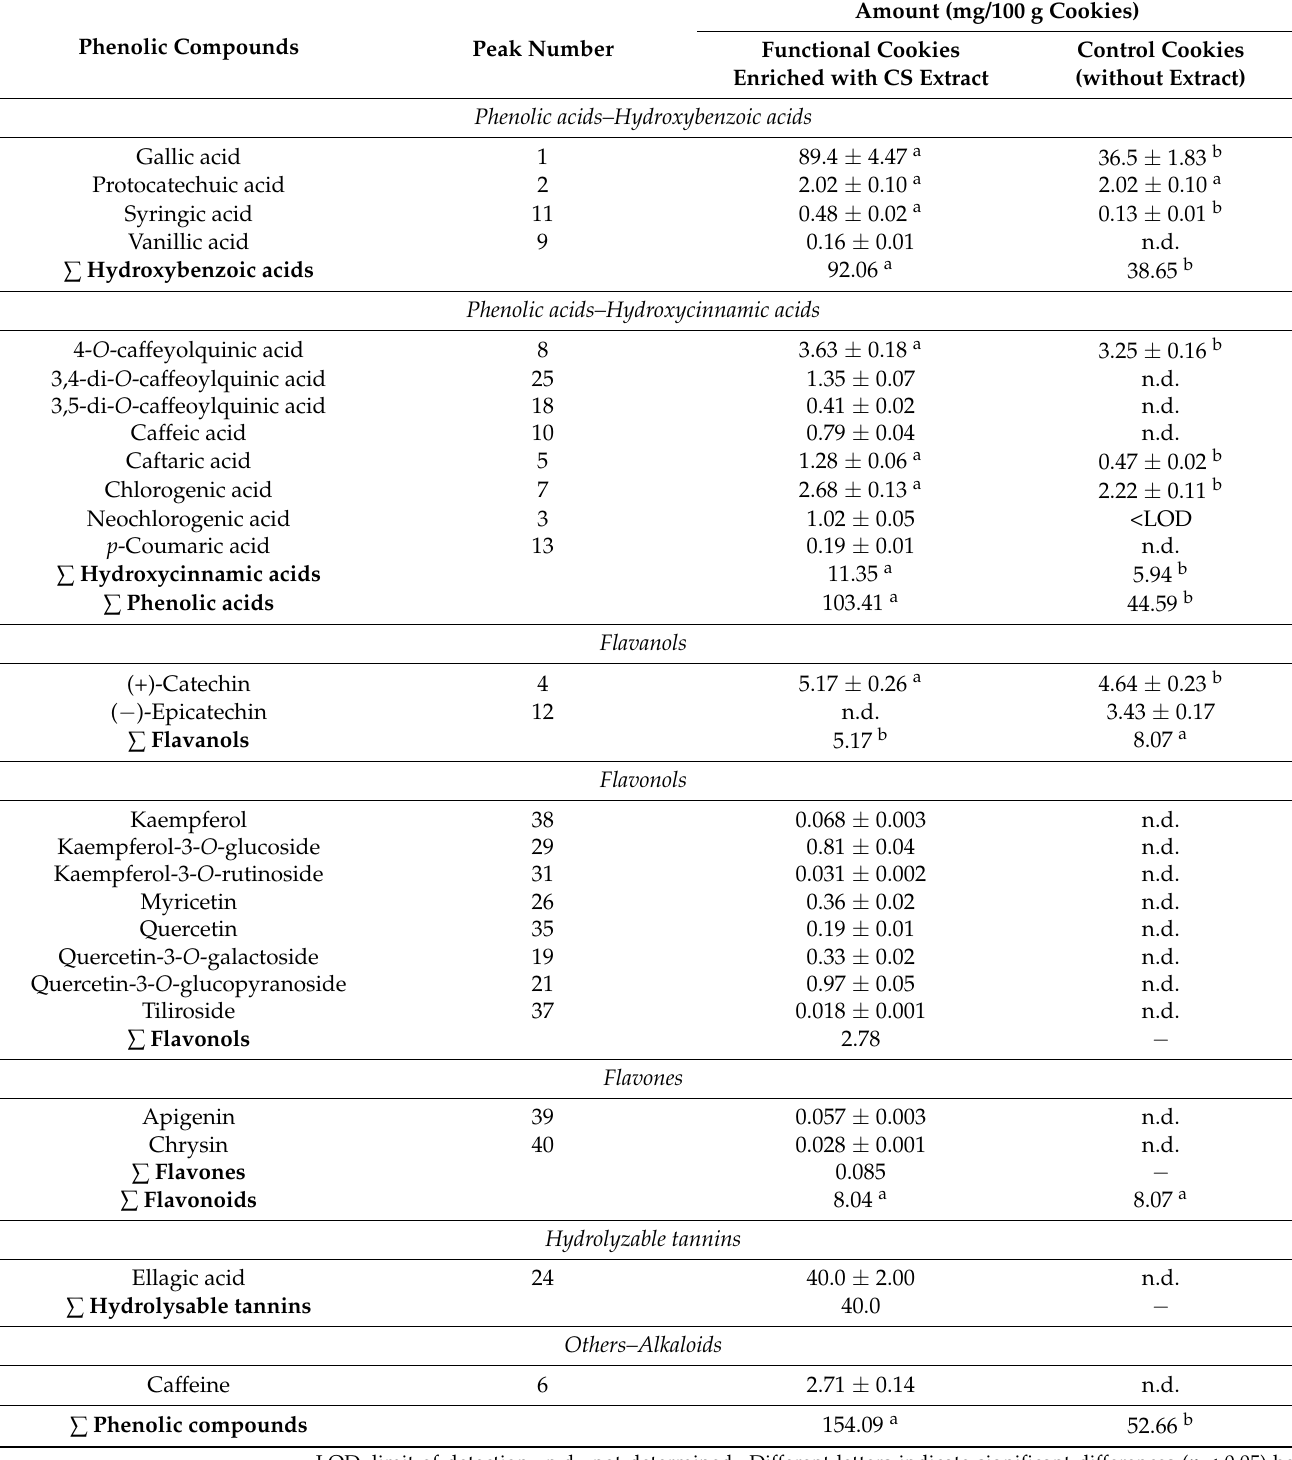
Table 5. Identification and quantification of phenolic compounds in functional cookies enriched with chestnut shells extract and control cookies (without